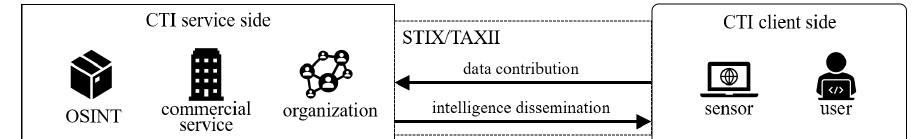
Figure 1. The system model of traditional cyber threat intelligence